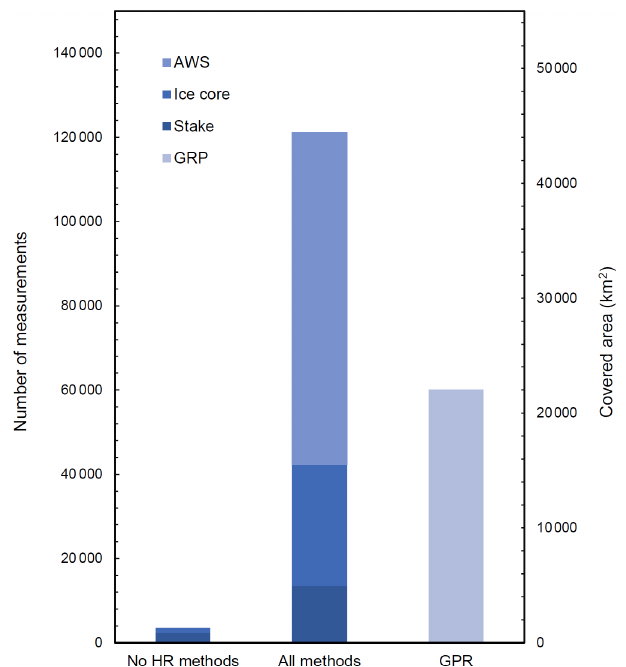
Figure 2. Bar charts indicating the number of the different types of measurement technique in the SMB observation dataset. The left bar demonstrates the distribution of approaches with the exclusion of high-resolution snow accumulation measurements and GPR mea- surements, and the area covered by GPR measurements is shown in the right